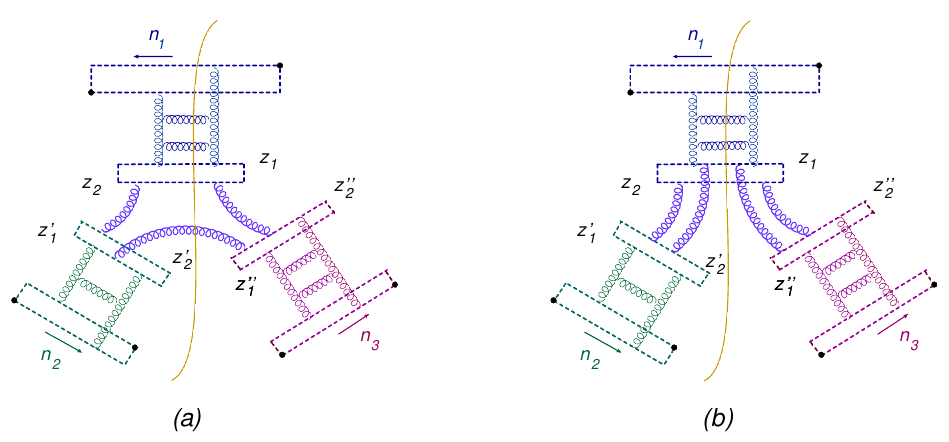
Figure 13 . Typical \cut diagrams" for the correlator of three Wilson